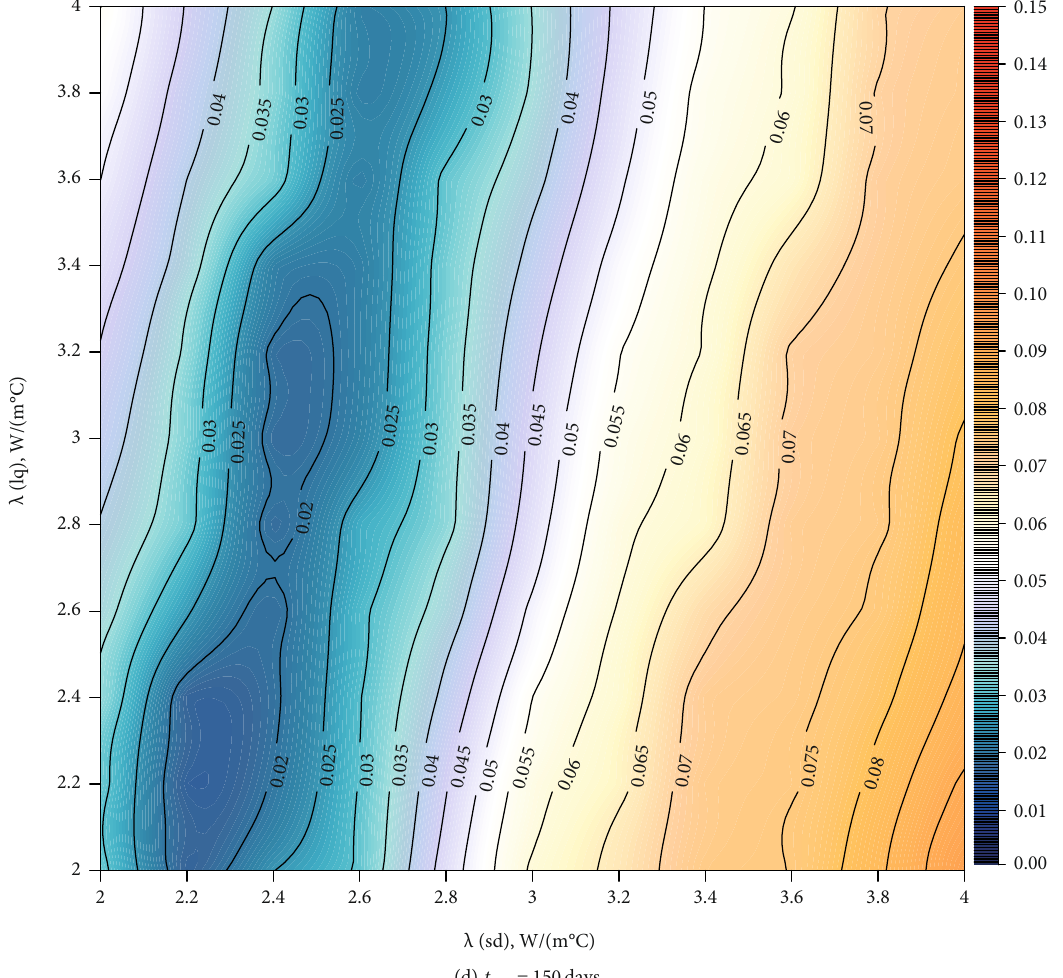
Figure 7: Isolines of the temperature discrepancy functional in the phase space of the minimization parameters ( λ freezing times for the chalk layer (shaft no. 2).